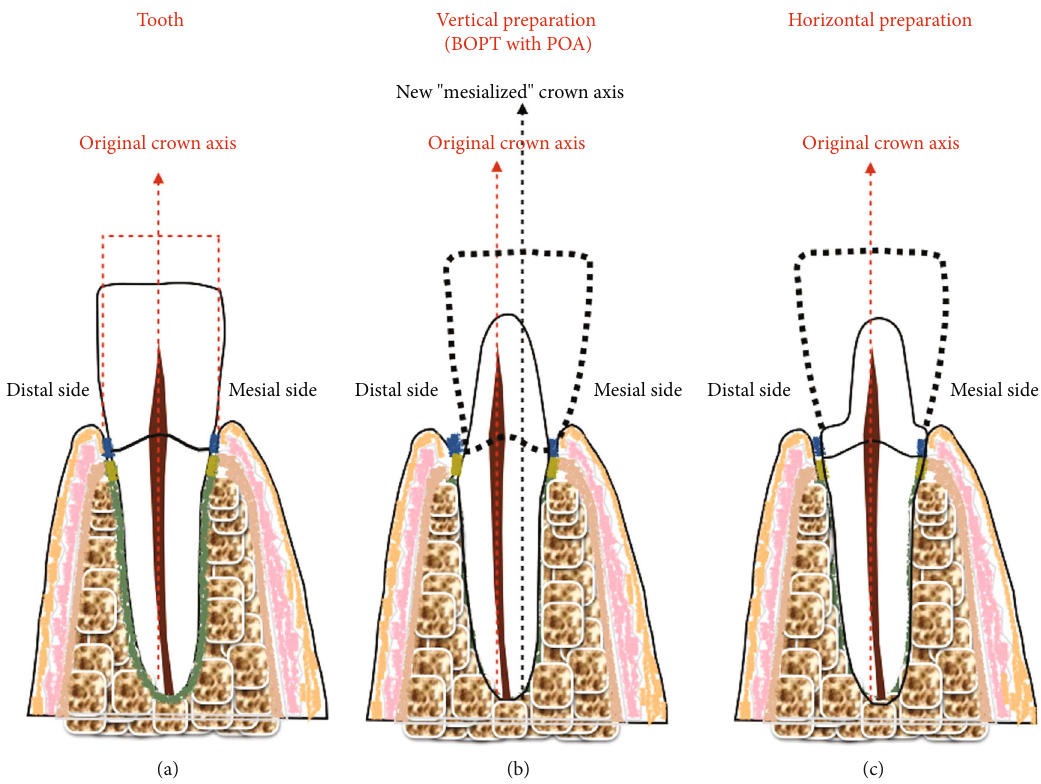
Figure 4: Mesialisation of the abutment tooth using the biologically oriented preparation technique (BOPT): (a) tooth; (b) the tooth is prepared without a fi nish line (BOPT), more on the distal than on the mesial side: this allows the mesialisation of the crown axis; (c) the tooth is prepared with a horizontal fi nish line, such that the crown restoration is in continuity with the external pro fi le of the root. Therefore, the crown axis cannot be moved without altering the tooth proportions, even if the distal side is prepared more than the mesial